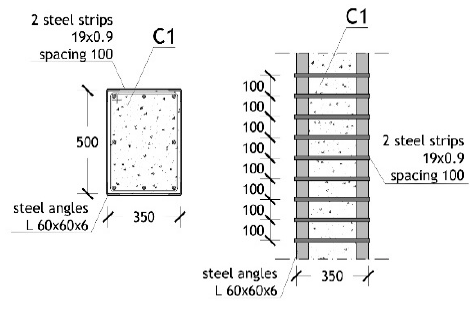
Figure 22. ACM-strengthened column.